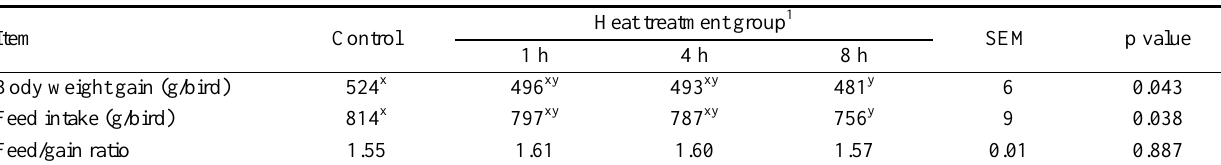
Table 2. Effects of heat-oxidized soy protein isolate on growth performance of broilers Item